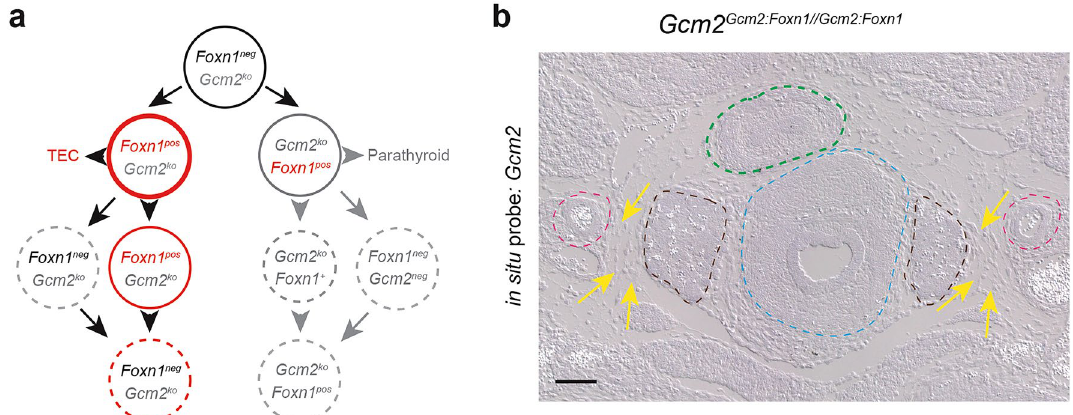
Figure 5. Lack of parathyroid tissue in E14.5 embryos homozygous for the Gcm2:Foxn1 knock-in allele. ( a ) Developmental trajectories under conditions of ectopic Foxn1 expression in Gcm2 -negative cells of the parathyroid; note that at this stage of development, parathyroid primordia are expected to be detectable only if Foxn1 expression rescues their apoptotic demise that occurs as a result of the lack of Gcm2 activity. ( b ) Failure to detect Gcm2-expressing parathyroid tissue. The sections were hybridised with a probe specific for the 5´-end of Gcm2, which is part of the chimaeric transcript emanating from the knock-in allele. The expected location of parathyroid is marked by yellow arrows; the common carotid arteries are indicated by red circles. Tissue sections representative of two mice. Scale bar, 0.1